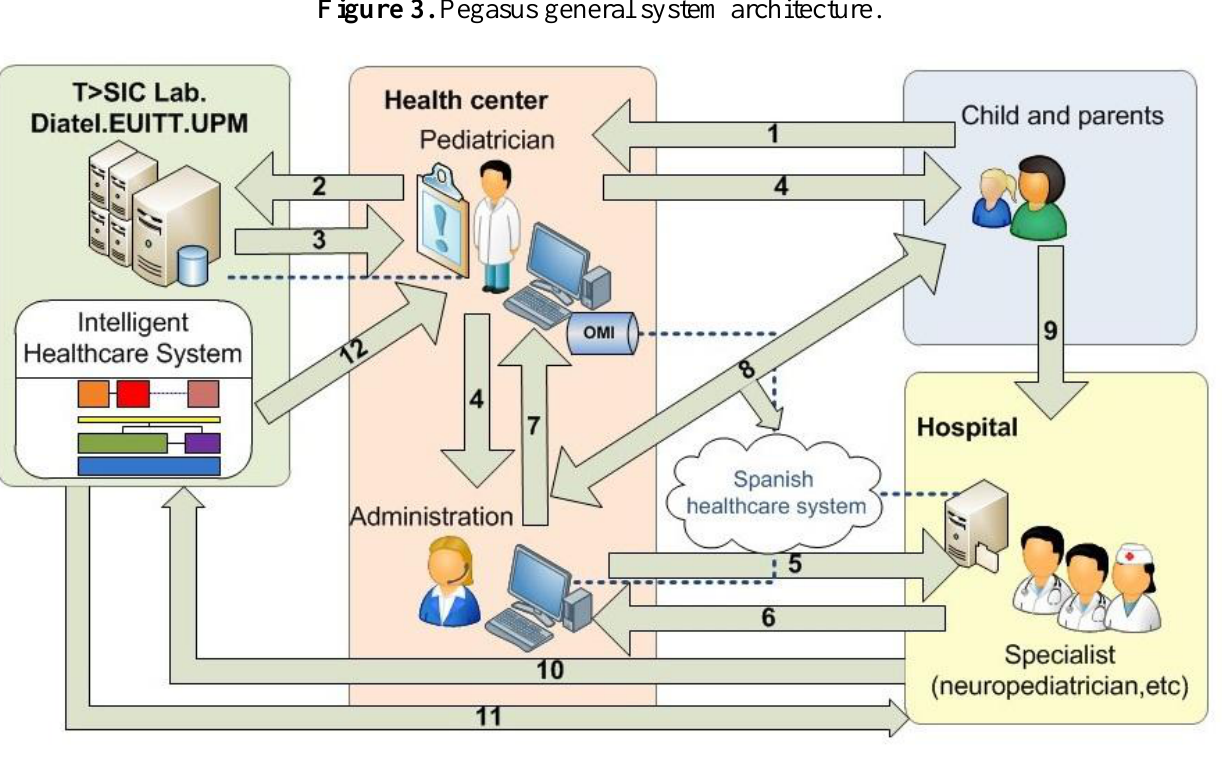
Figure 3. Pegasus general system